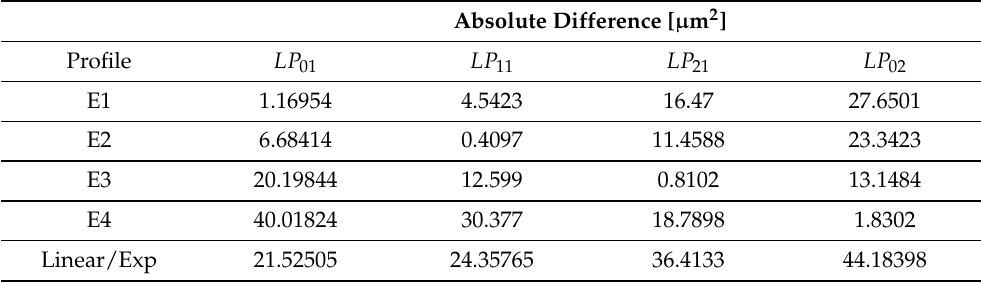
Table 1. Absolute difference in effective mode area A ef f at the interface between the interconnecting structure and the FMF.